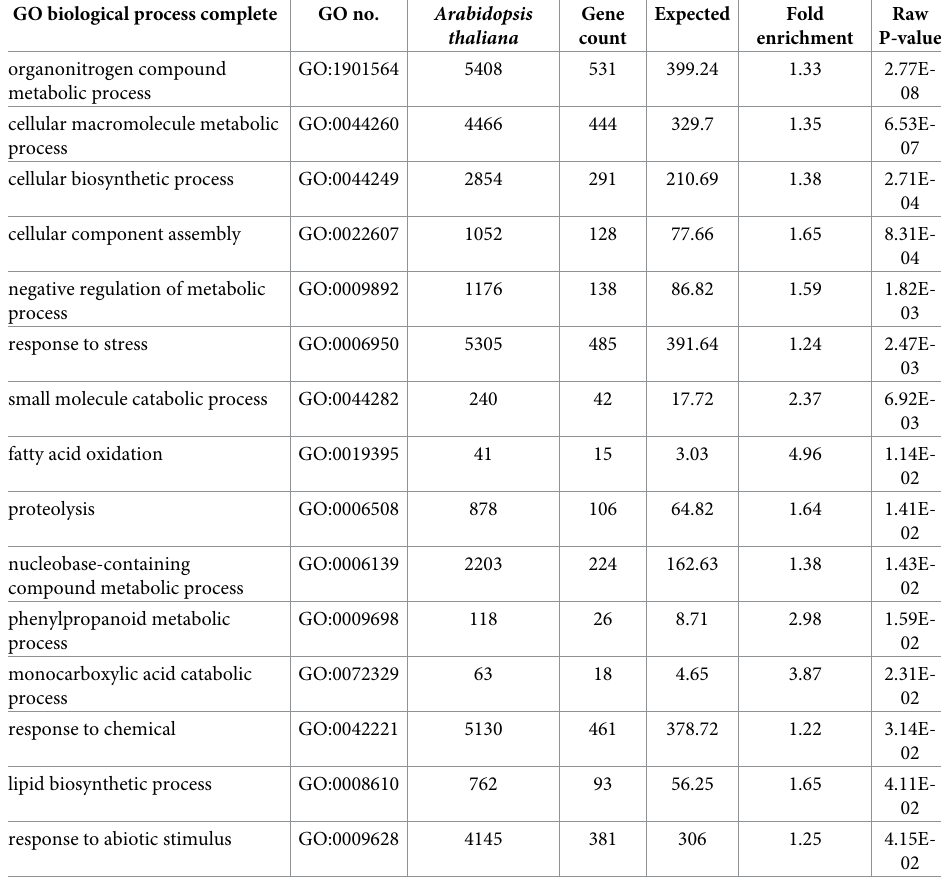
The targets were compared with Arabidopsis genes to identify overrepresented categories (false-discovery rate � 0.05). Only the lowest categories in the GO hierarchy are